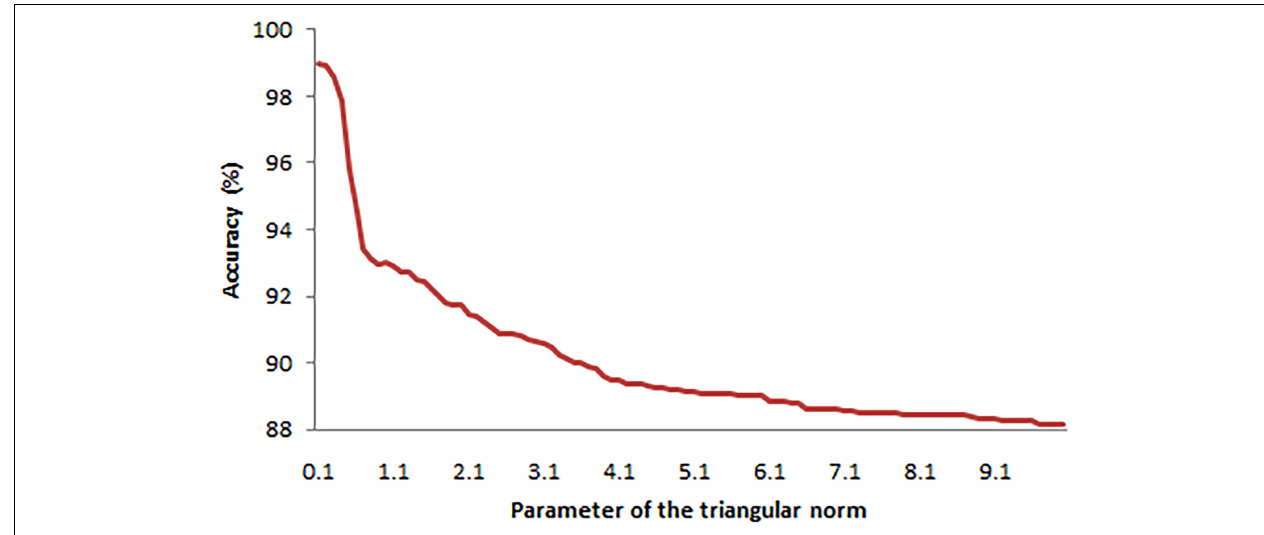
FIGURE 4 | Averages of accuracies achieved with top aggregation